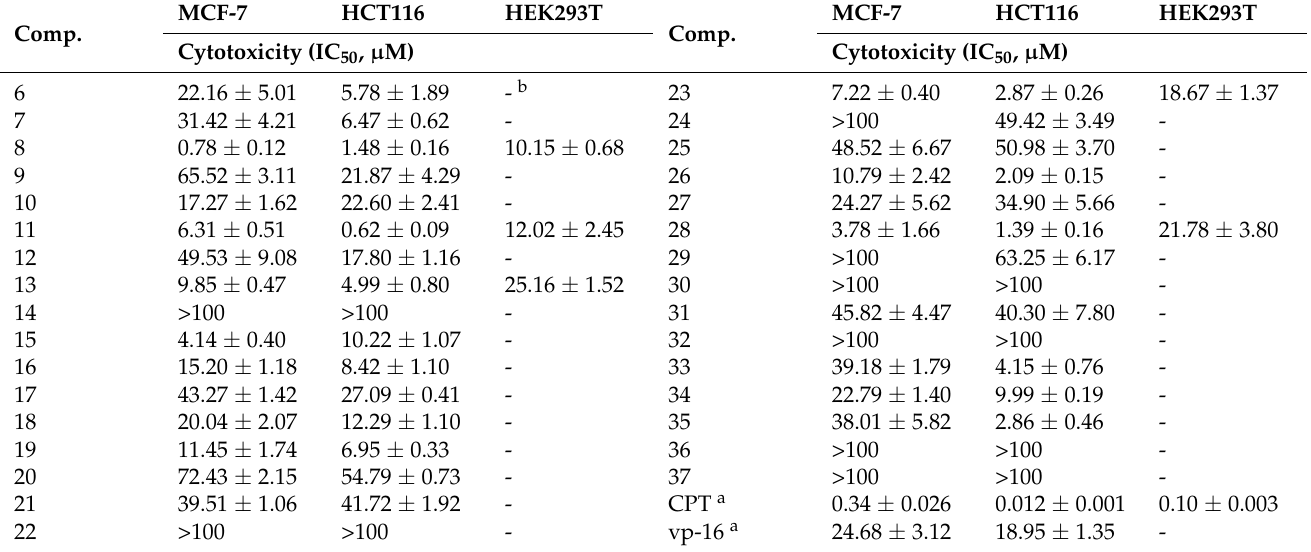
Table 2. Cytotoxicity of synthesized